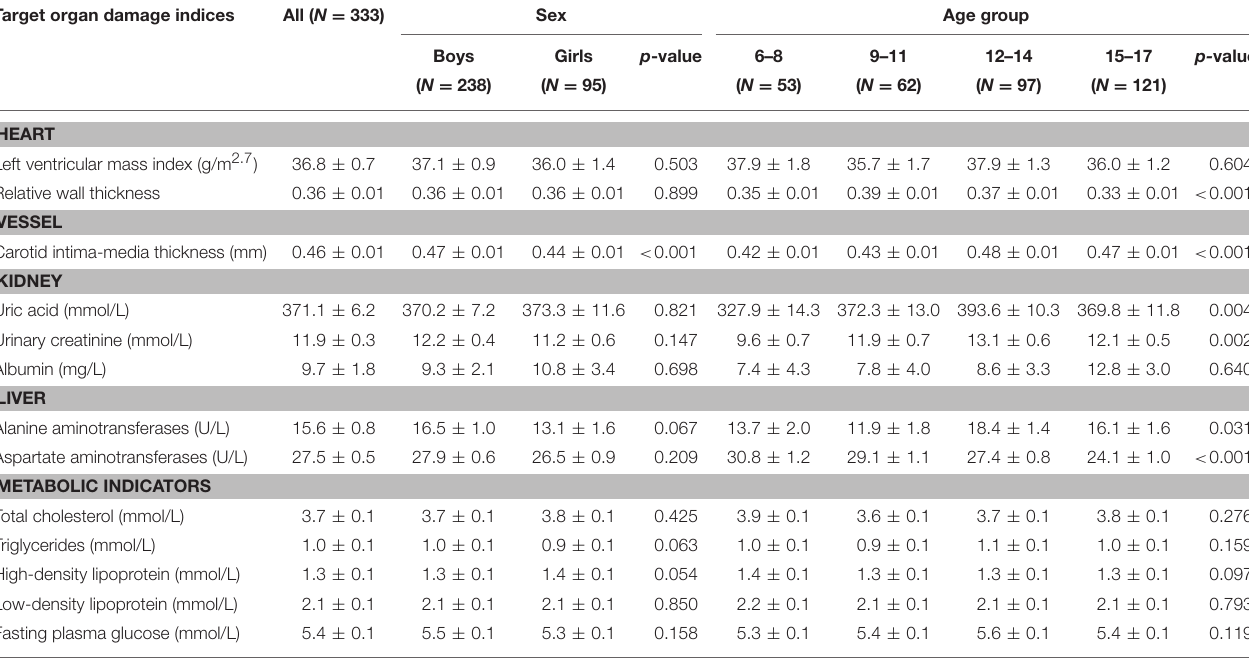
TABLE 2 | Mean values of target organ damage indices and biochemical indicators by sex and age. Target organ damage indices